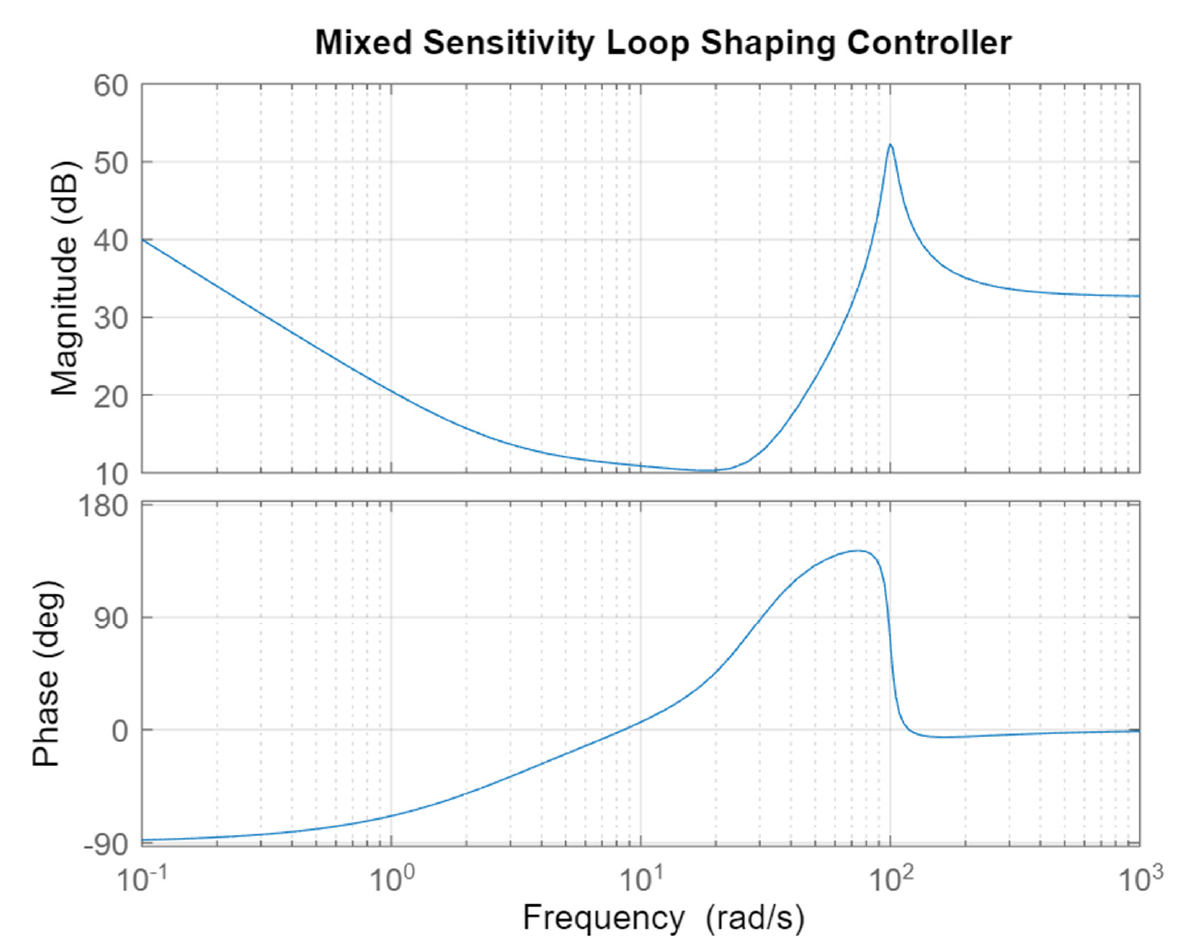
Figure 6. Bode Plot of the Mixed Sensitivity Design controller.